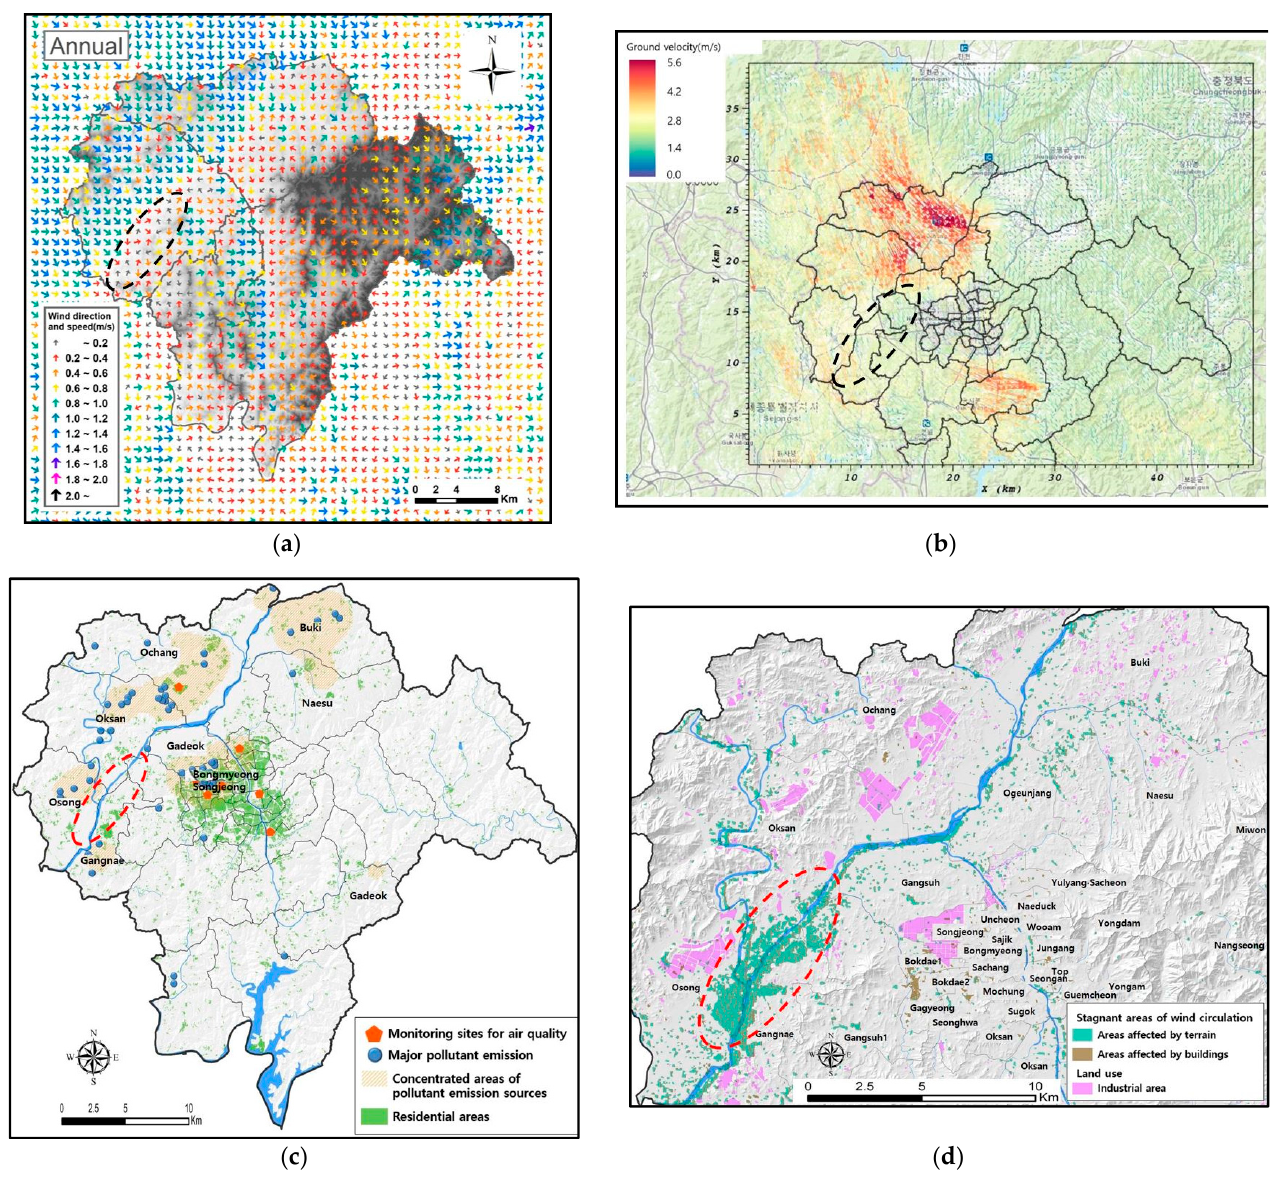
Figure 6. Application cases of wind field maps to environmental plans in Cheongju-si, Korea: ( a ) Annual wind field map of Cheongju-si, Korea via the WRF-CALMET model, ( b ) predicted wind speed distribution at 19:00 in July, Cheongju-si, Korea via the CAS model with 30-year average me- teorological values, ( c ) distribution of air pollutant emission sources (yellowish brown) and residen- tial areas (green), ( d ) distribution of stagnant areas of wind circulation (green) and industrial areas (pink). (Source of ( b – d ): [23], translated and added dashed lines for a stagnant area of wind circula- tion with consent of publishers).